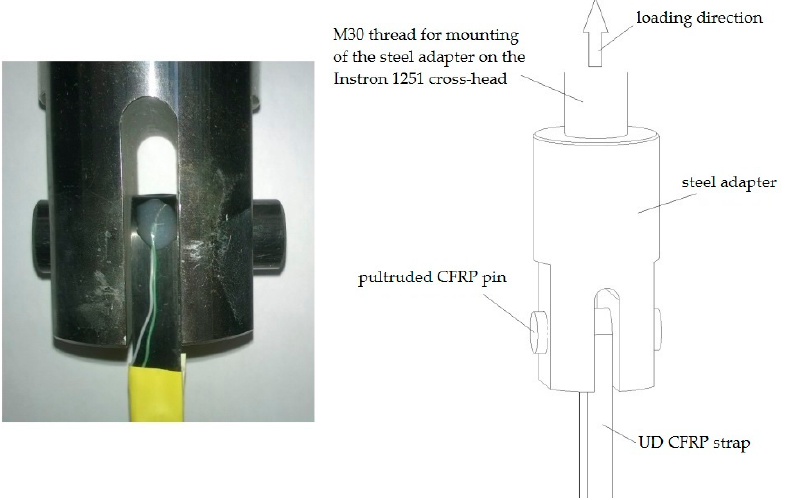
Figure 3. Mounting of the pins and straps in the testing machine.